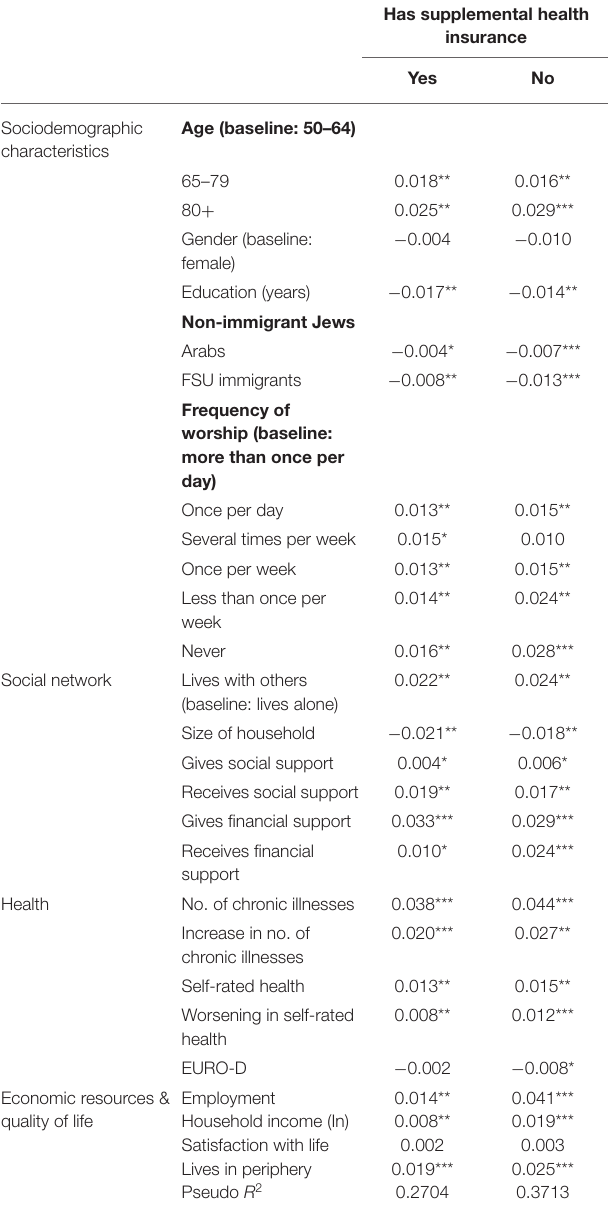
TABLE 5 | Probability models for out-of-pocket expenditure on healthcare services among holders of supplemental insurance aged 50 + in investigation time 1, panel (marginal